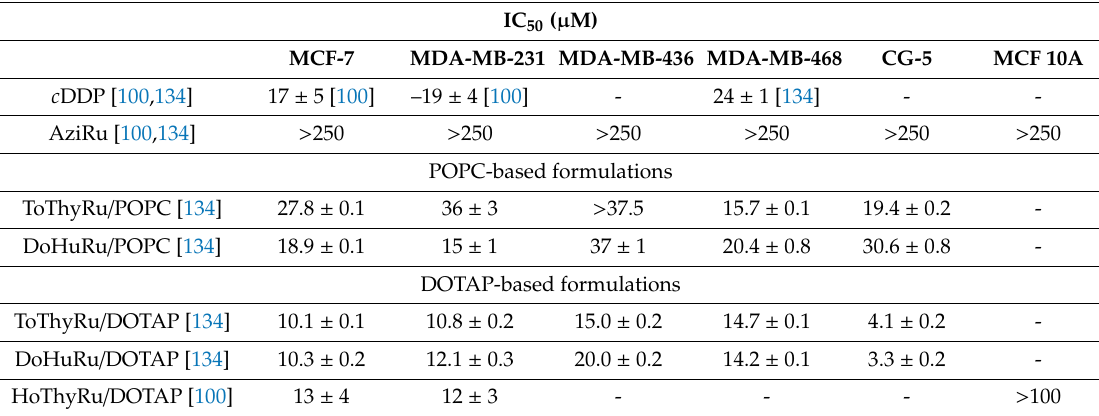
Table 2. IC 50 values ( µ M) relative to cisplatin ( c DDP), AziRu and the e ff ective ruthenium concentration inserted in the Ru(III)-incorporating POPC- and DOTAP-based liposomes in the indicated BCC lines following 48 h of incubation in vitro. IC 50 values are reported as mean ±